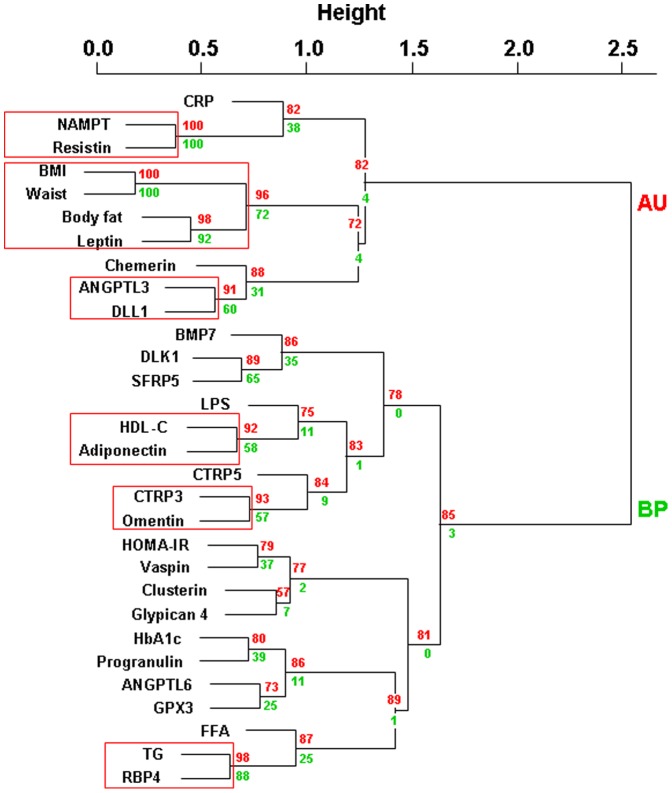
Hierarchical clustering of serum adipokine concentrations and clinical parameters in obese patients (n = 141).We provide approximately unbiased (AU, numbers in red) p-values and bootstrap probability (numbers in green) values as measures of certainty for clusters. Values are based on 10,000 bootstrapping replicates. AU≥90% was considered as strong evidence for the cluster and is marked by red rectangles (only largest possible clusters are marked). Abbreviations: BMI, body mass index; HOMA-IR, Homeostatic Model Assessment; FFA, free fatty acids; CRP, high sensitive C-reactive protein; ANGPTL 3, angiopoietin-like protein 3; ANGPTL 6, angiopoietin-like protein 6; BMP7, bone morphogenetic protein 7; CTRP3, complement C1q tumor necrosis factor-related protein 3; CTRP5, complement C1q tumor necrosis factor-related protein 5; LPS, Lipopolysacharid (Endotoxin); GPX3, glutathione peroxidase 3; DLL1, delta-like protein 1; DLK1, preadipocyte factor 1; NAMPT, nicotinamide phosphoribosyltransferase (visfatin); RBP4, retinol binding protein 4; SFRP5, secreted frizzled-related protein-5; TG, triglycerides